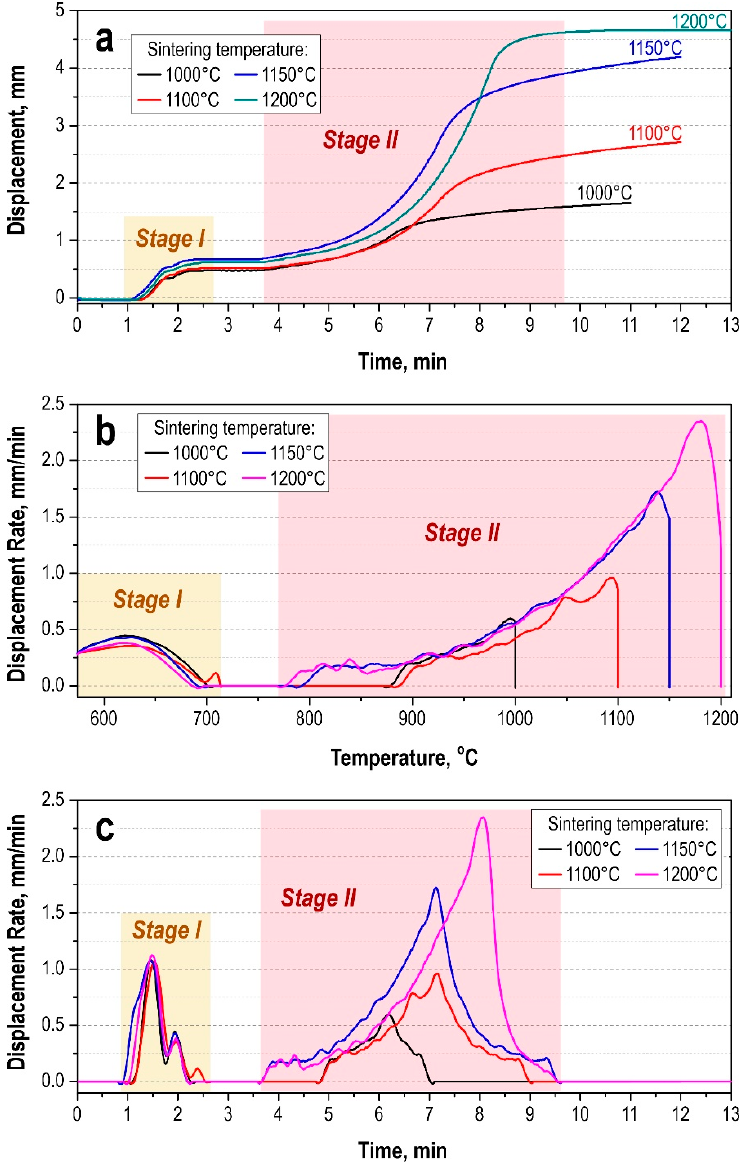
Figure 2. Compaction of WC-10wt%Co powder with different SPS temperatures (1000, 1100, 1150, 1200 °C): ( a ) displacement/time; ( b ) displacement rate/temperature; ( c ) displacement rate/time.